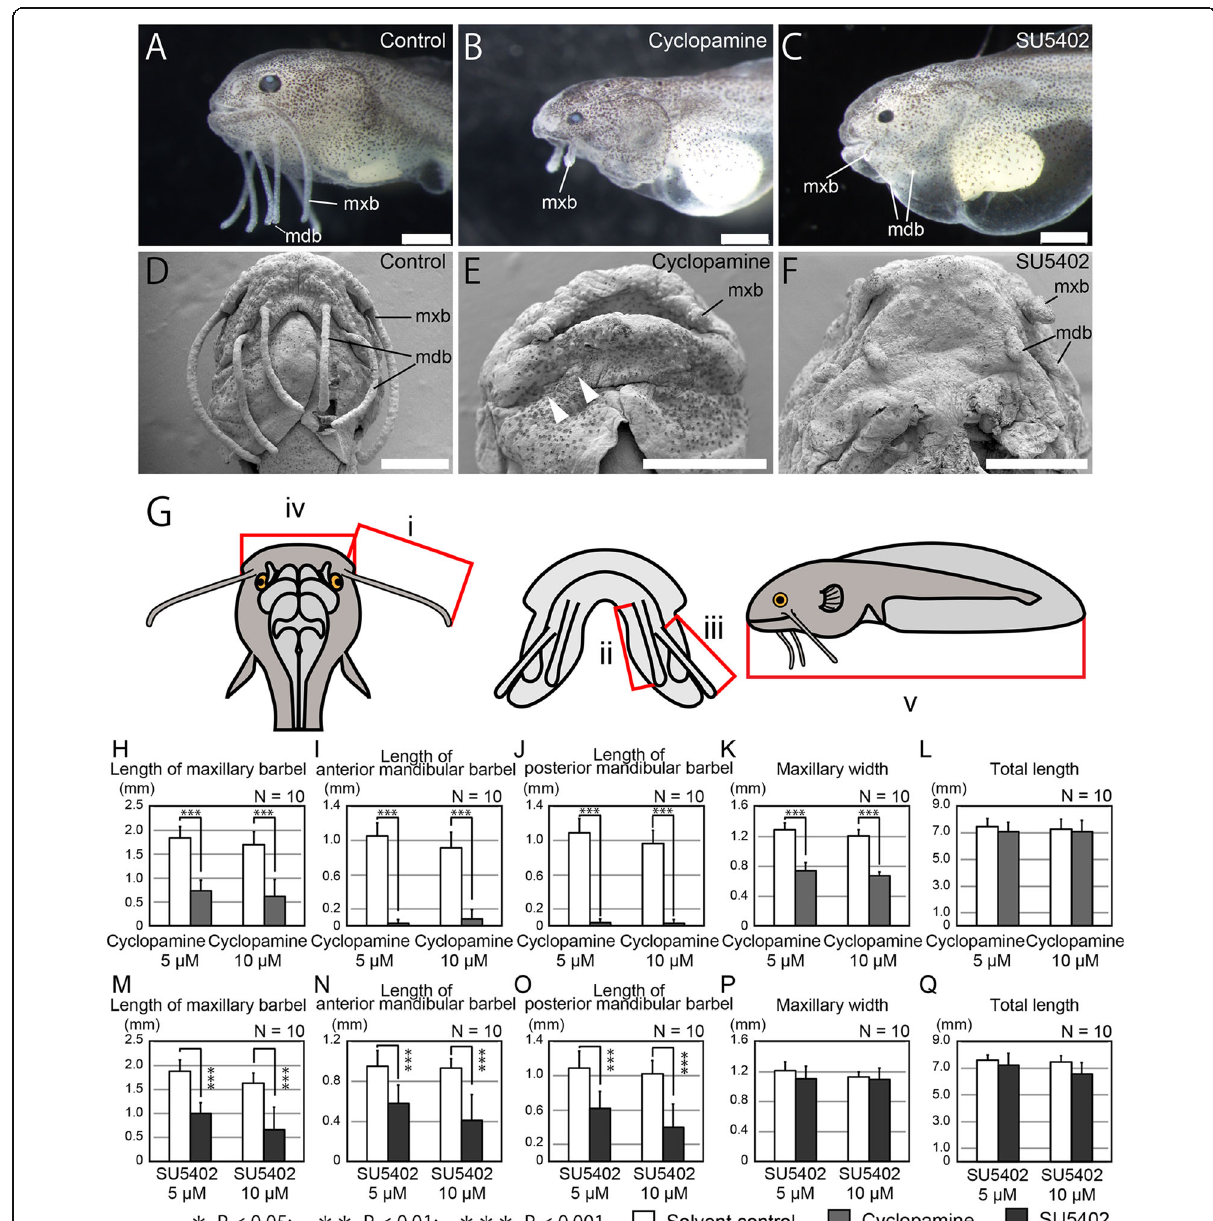
Fig. 6 Effects of SHH and FGF signal inhibitors on morphology of catfish embryos . Specimens were observed by microscopy ( a – c ) and SEM ( d – f ). In the developing catfish, SHH and FGF inhibitors (10 μ M of Cyclopamine in b , e and 10 μ M of SU5402 in c , f ) affect morphogenesis of the craniofacial region. SHH inhibitor induced malformation of mandibular apparatus and reduced the length of maxillary barbels ( b , e ). In addition, mandibular barbels disappeared in cyclopamine-treated embryos (arrowheads in e ). FGF inhibitor caused malformation of maxillary and mandibular barbels ( c , f ), whereas the craniofacial morphology appeared normal. g shows schematics of the dorsal (left), ventral (middle), and lateral (right) sides of the catfish. i – v are morphological cues used for quantification: i, length of the maxillary barbel; ii, length of the anterior mandibular barbel; iii, length of the posterior mandibular barbel; iv, width of the maxillary region; v, total length. h – q , quantification of the length of barbels ( h – j , m – o ), width of maxillary region ( k , p ), and total length ( l , q ) in cyclopamine-treated embryos ( h – l ) and SU5402-treated embryos ( m – q ) at 5 dpf. Inhibition of SHH induced significant abnormality in both maxillary and mandibular barbels ( h – j ) and maxillary apparatus ( k ). However, cyclopamine did not affect total length ( l ). Inhibition of FGFs significantly induced abnormality in both maxillary and mandibular barbels ( m – o ), while maxillary width and total length appeared normal ( p , q ). Error bars are standard deviations (SD). Data denoted by the same letter do not differ significantly (* P >0.05; ** P >0.01; *** P >0.001) based on Tukey ’ s HSD test or the Steel – Dwass test after analysis of homogeneity of variance with Bartlett ’ s test. mdb, mandibular barbel; mxb, maxillary barbel. Anterior is left in a – c and the upper side in d – f . Scale bars are 500 μ